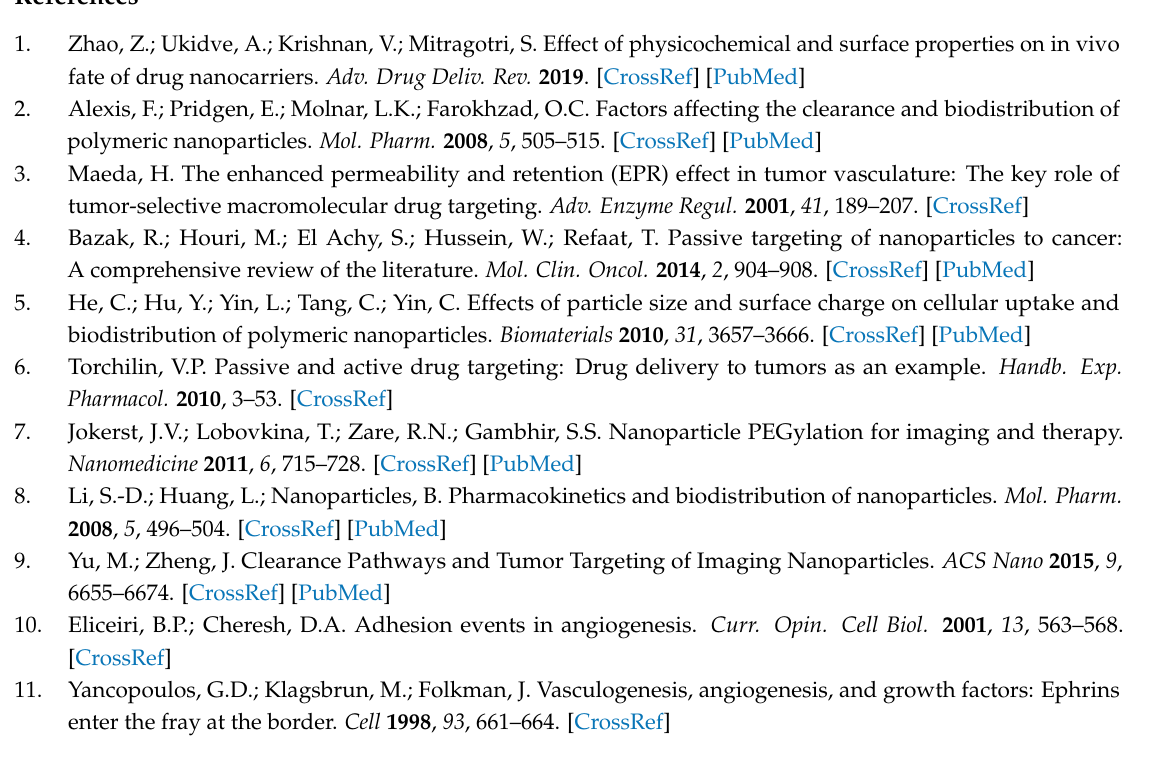
Figure S2: DLS analysis of PPG-cRGD-IR-780 NPs. Figure S3: DLS analysis of PPG-cRGD-IR-780 NPs in mouse plasma. Figure S4: Confocal images of free